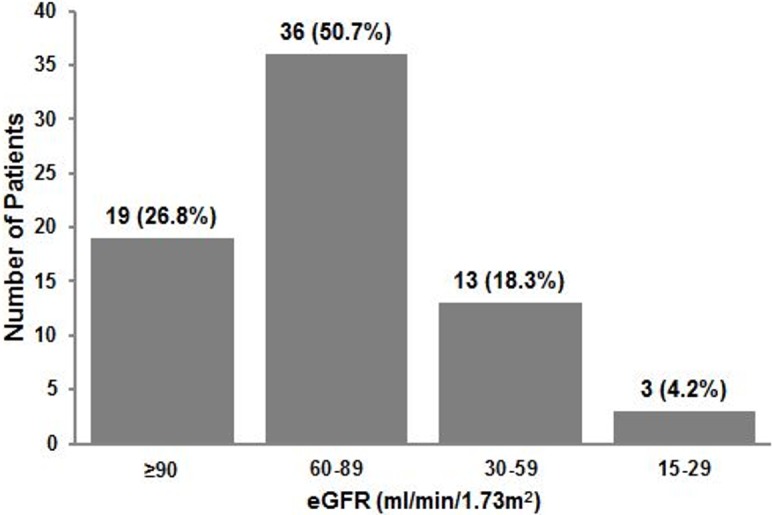
Categorization of patients according to eGFR category at the end of study.